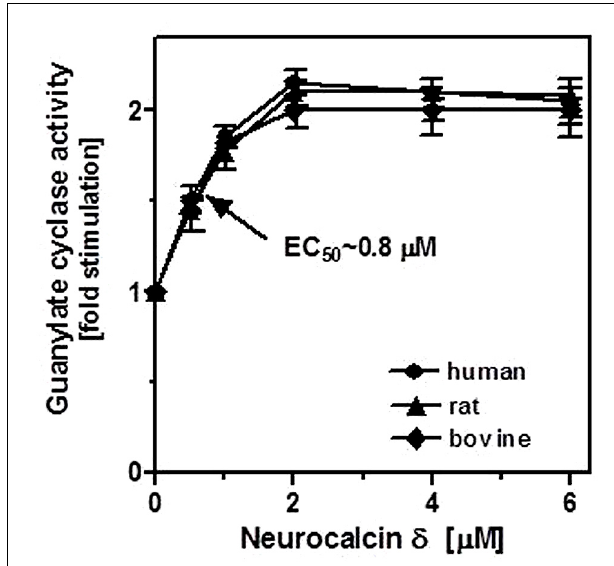
FIGURE 4 | Effect of NC δ on the guanylate cyclase activity in the membranes of testes. Membranes of human, rat, and bovine testes were isolated as described in “Materials and Methods”.They were assayed for guanylate cyclase activity in the presence of indicated concentrations of NC δ and 100 μ M Ca 2 + . Each experiment was done in triplicate, and repeated two times.The results shown (mean ± SD) are from these experiments.